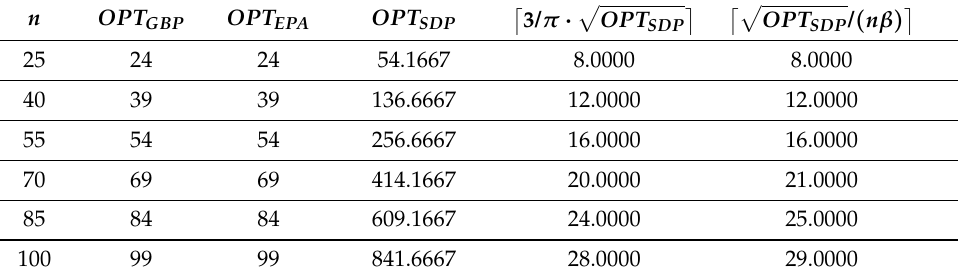
Table 2. Results of the EPA algorithm on complete graphs K n